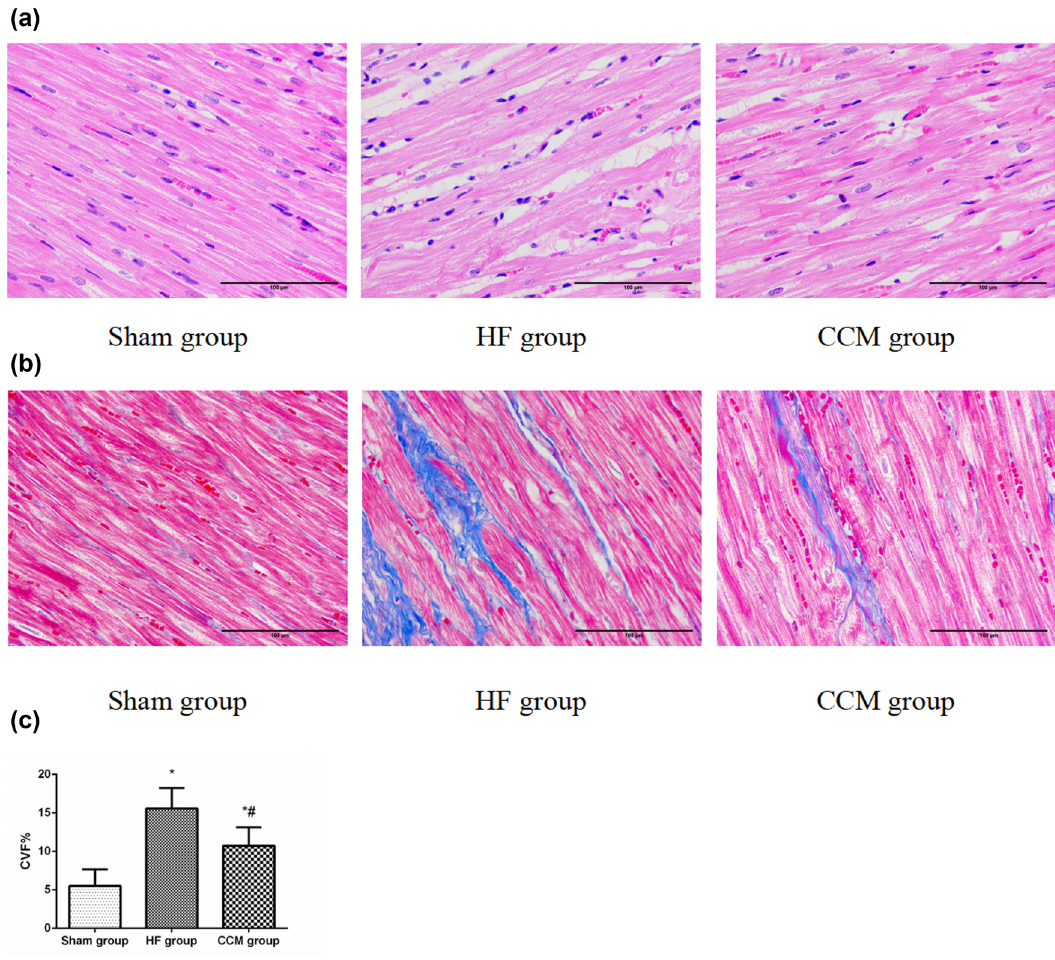
Figure 2: CCM treatment ameliorates pathological changes in cardiac tissues. ( a ) H and E staining of cardiac tissues ( 400 × magni fi cation ) . ( b ) Masson ’ s trichrome staining of cardiac tissues ( 400 × magni fi cation ) . ( c ) The CVF of myocardial tissues was quantitated. Data are expressed as mean values ± SD ( * P < 0.05 compared with the sham group; # P < 0.05 compared with HF group )